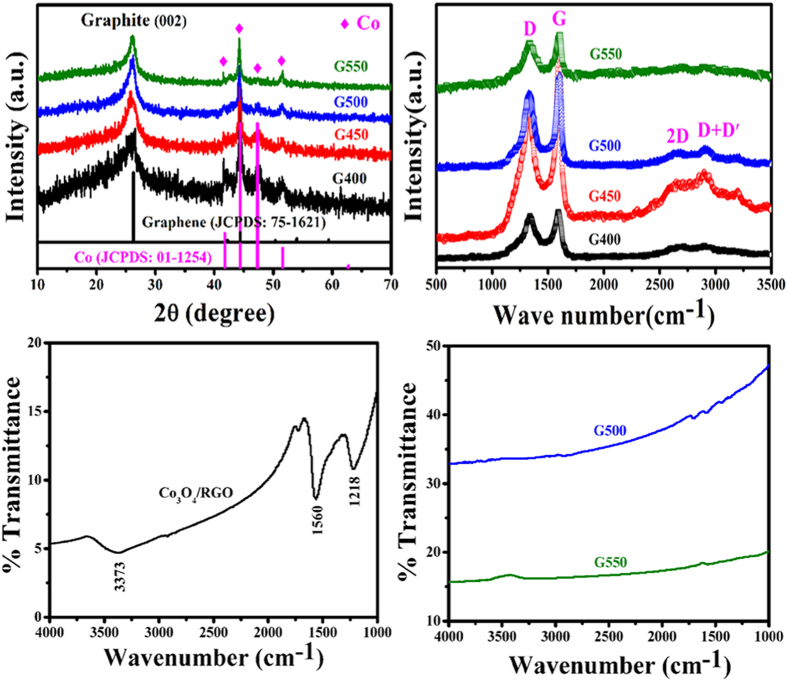
(a) XRD patterns, (b) Raman spectra, and (c,d) FT-IR spectra of Co3O4/RGO and the as-prepared hybrids.